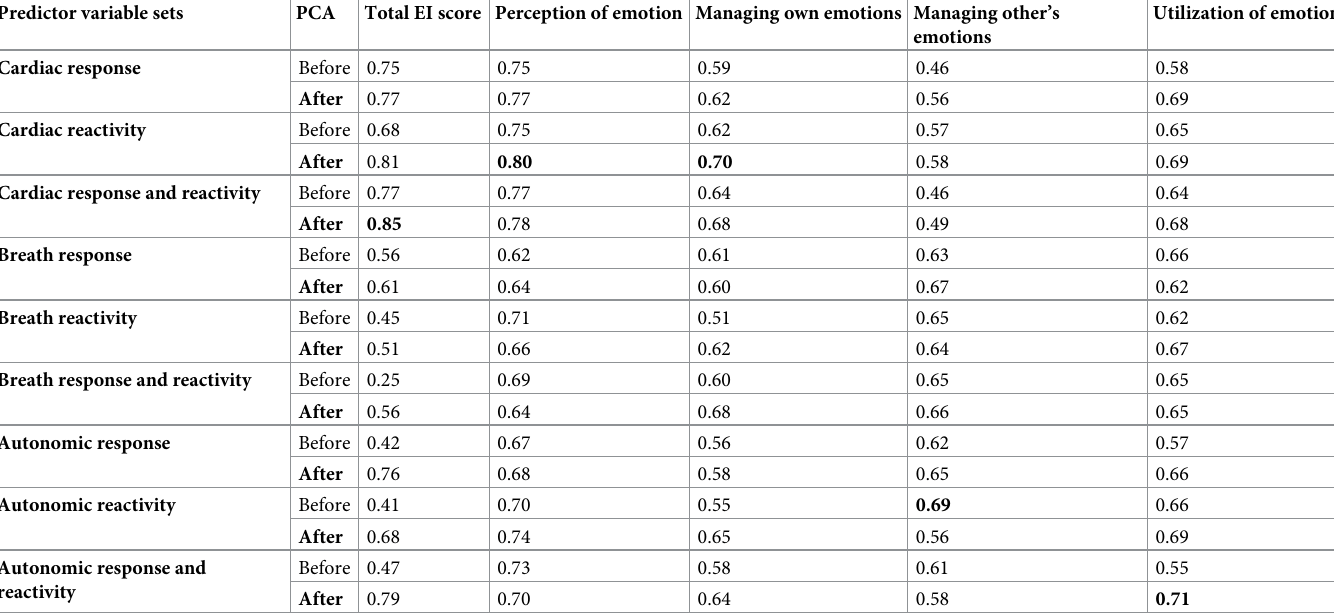
Table 14. F1 scores for